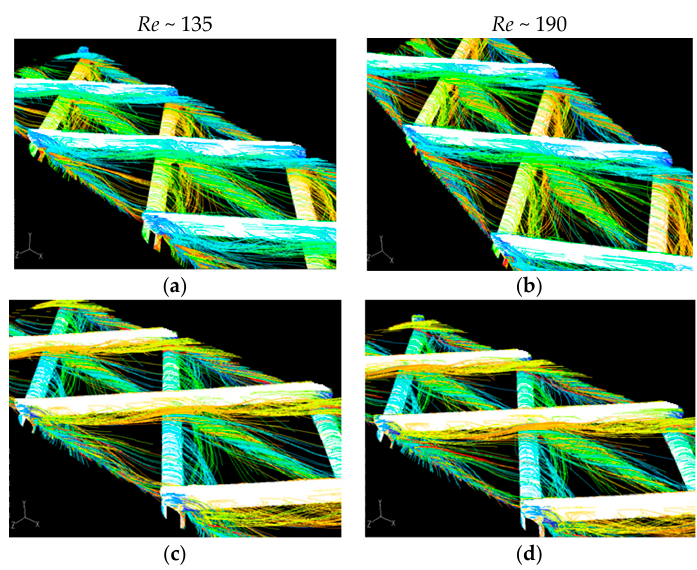
Figure 3. An instantaneous view of fluid-particle pathlines for different fouling-layer thicknesses ( a , b ) h / D = 0.025; ( c , d ) h / D = 0.10; and Reynolds number ( a , c ) Re ~ 135; ( b ), ( d ) Re ~ 190.